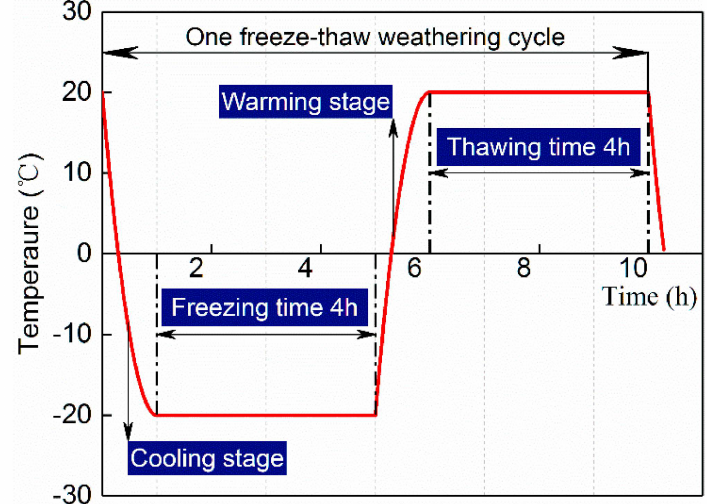
Figure 4. Temperature variation curves for one F&T weathering